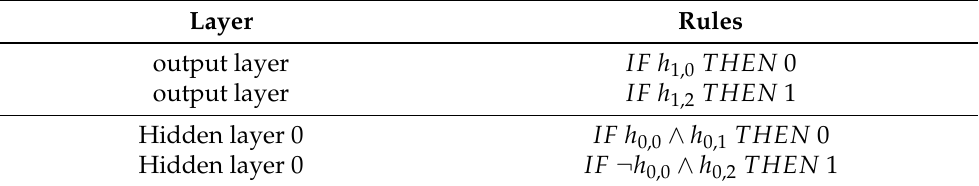
Table A10. DEXiRE Intermediate rule set for the banknote authentication dataset.